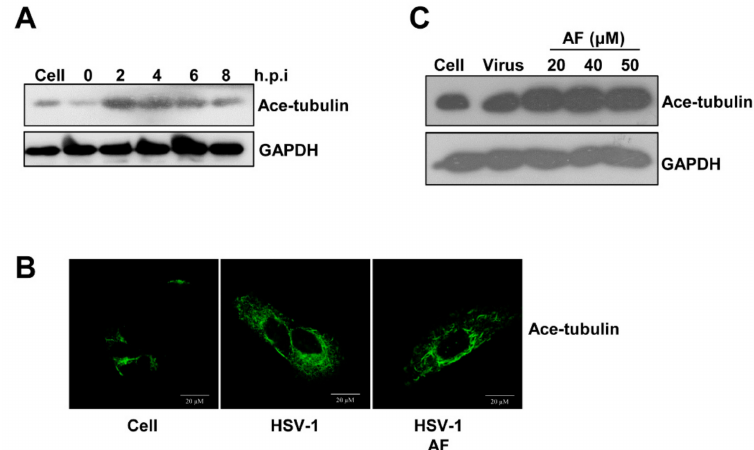
Figure 6. Amentoflavone does not a ff ect microtubule organization. ( A ) SK-N-SH cells seeded in 30 mm 2 dish were infected with HSV-1 (MOI = 10) at 4 ◦ C for 2 h, and were then incubated at 37 ◦ C for di ff erent time points. Total proteins were extracted to detect the level of acetylated tubulin. ( B ) The SK-N-SH cells infected with HSV-1 were treated with amentoflavone or DMSO (cell and HSV-1 group) for 2 h at 37 ◦ C. The cells were then fixed and stained with anti- ace-tubulin primary antibody. ( C ) SK-N-SH cells seeded in a 30 mm 2 dish were infected with HSV-1 (MOI = 10) at 4 ◦ C for 2 h, and then incubated at 37 ◦ C in the presence of amentoflavone or DMSO (HSV-1 control group) for 2 h at 37 ◦ C. Total proteins were extracted to detect the level of acetylated